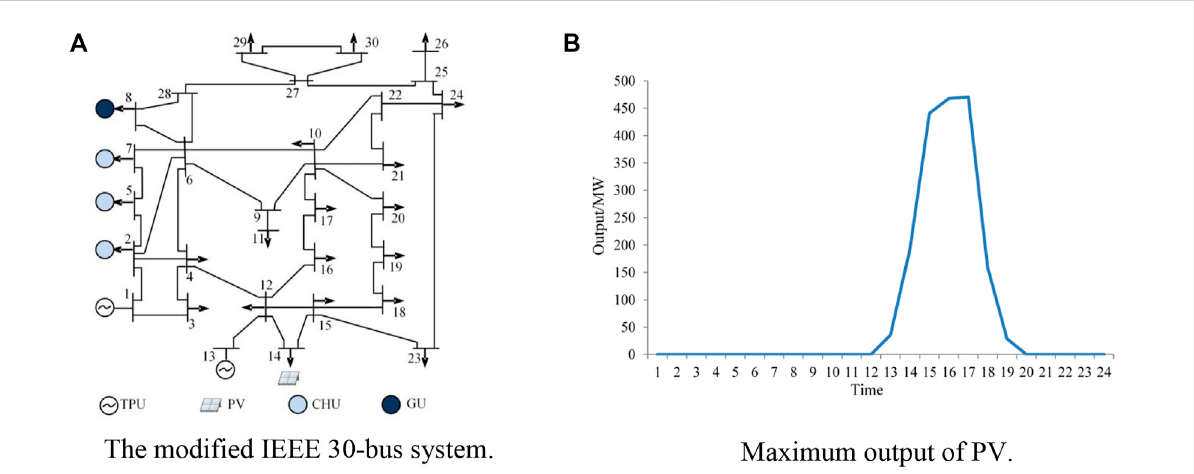
FIGURE 3 The location of each generator unit and maximum output of PV. (A) The modi fi ed IEEE 30-bus system. (B) Maximum output of